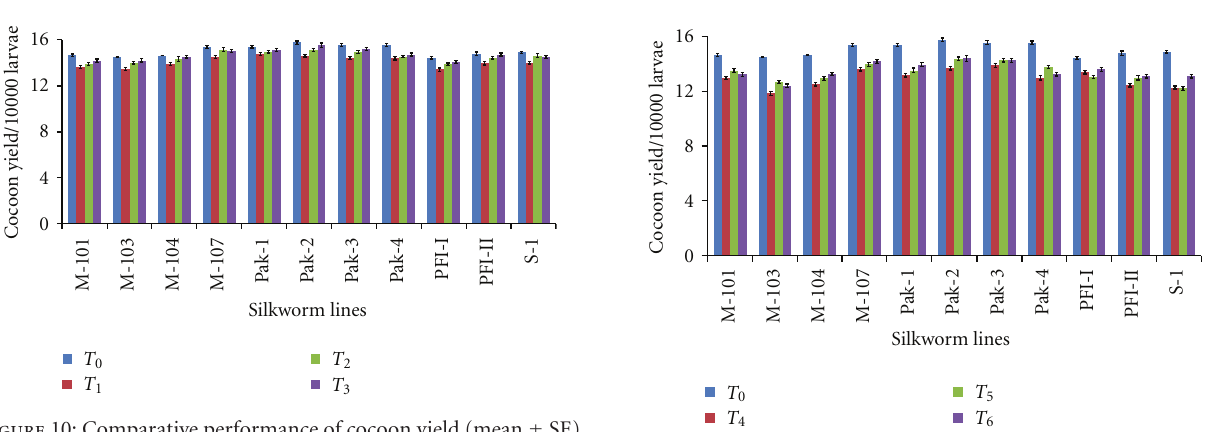
Figure 10: Comparative performance of cocoon yield (mean ± SE) of eleven silkworm lines at 25 ± 1 ◦ C in combination with 55, 65, and 75% RH and controlled conditions of temperature and RH (25 ± 1 ◦ C and 70–80% RH, resp.).